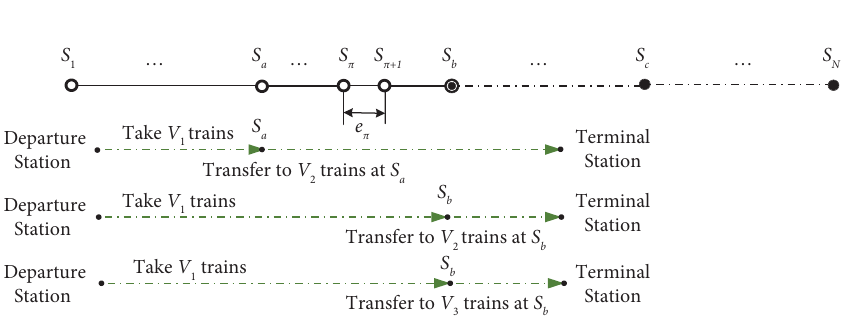
Figure 6: Travel scheme of type 13 passenger flows.